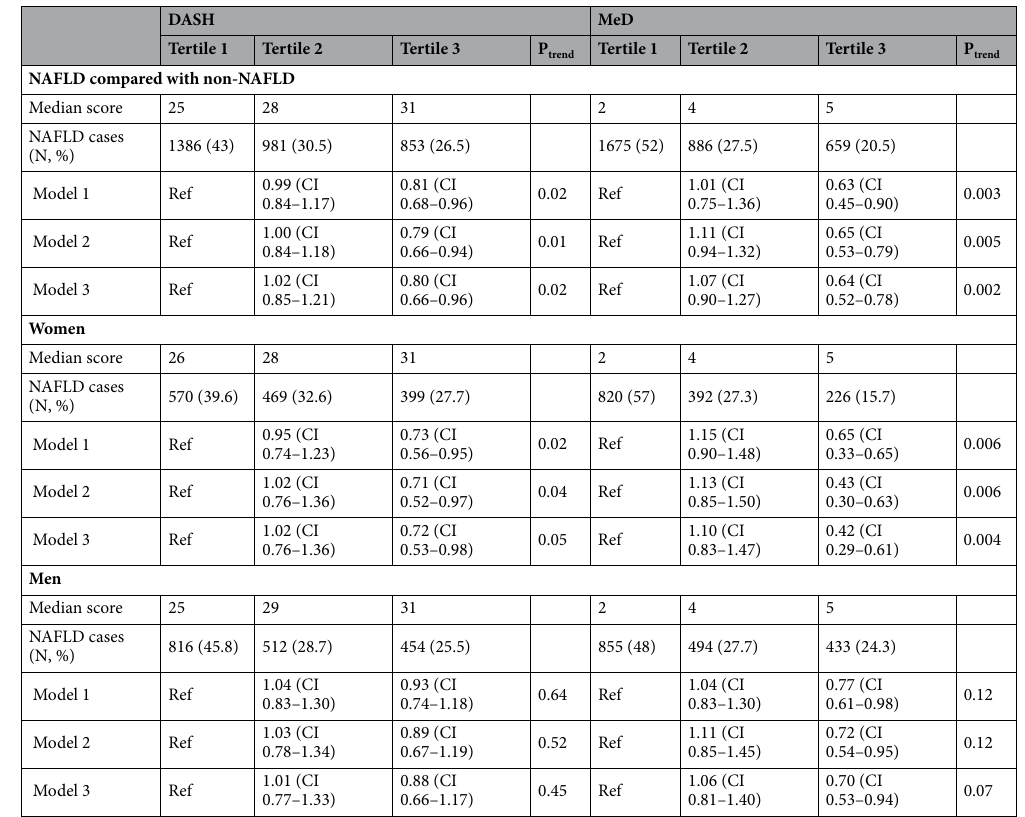
Table 3. Multivariable-adjusted odds ratio and 95% confidence intervals for nonalcoholic fatty liver disease (NAFLD) according to tertiles of dietary patterns in all adult participants and stratified by sex, Amol Cohort Study, Iran, 2016–2017 (n 3220). DASH: Dietary Approaches to Stop Hypertension, MeD: Mediterranean diet, Ref: reference category. Model 1: adjusted for age and sex. Model 2: Additional adjustment for BMI, energy intake, physical activity, and smoking. Model 3: additional adjustment for Lowering serum lipid drugs, Lowering HPTN drugs, Lowering serum glucose drugs, residual areas, heart disease,